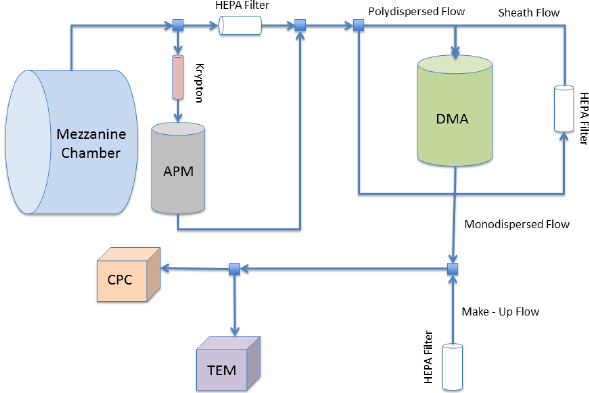
Figure 1. Schematic of the APM–DMA–TEM setup. Figure 1: Schematic of the APM-DMA-TEM setup 753 density equivalent) 50 and 100 nm particle size range.